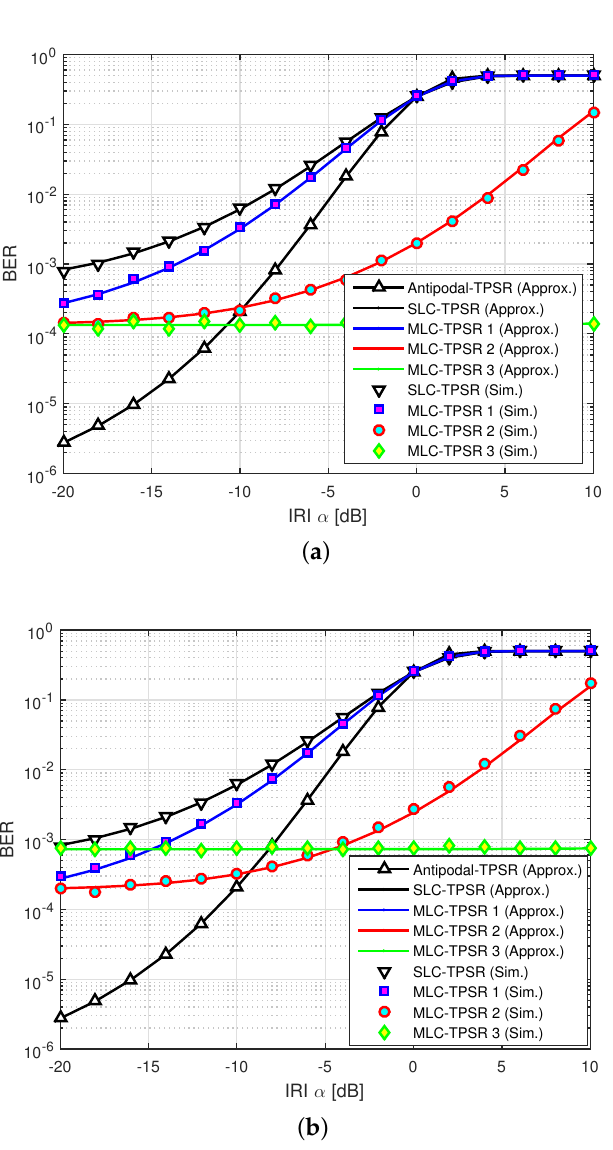
Figure 4. Bit error rate (BER) performance according to inter-relay interference (IRI) ( E b / N 0 = − 4 dB, G p = 30 ) . ( a ) Primary relay; ( b ) secondary